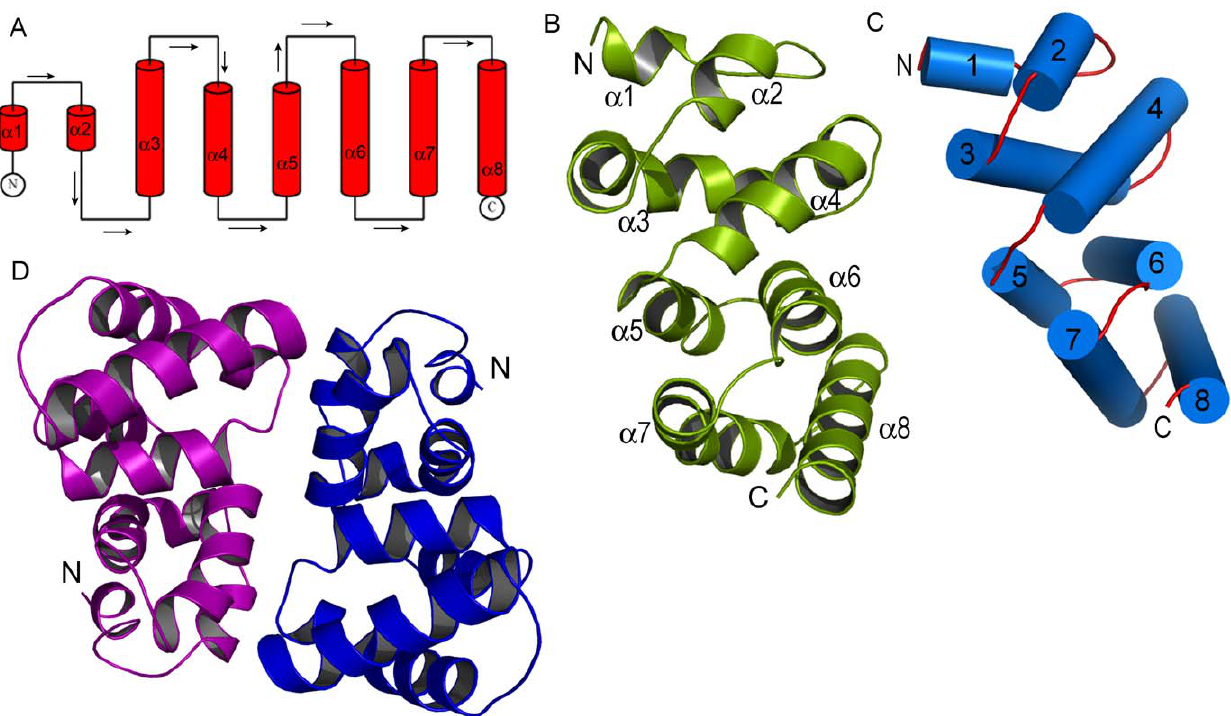
Figure 2. Structure of singleton Cthe_2751. (A) Topology diagram of the structure. (B) Cartoon representation of Cthe_2751 with helices shown as cylinders in (C) to depict the contour, pairing and stacking. (D) Cartoon representation of a dimer of Cthe_2751.